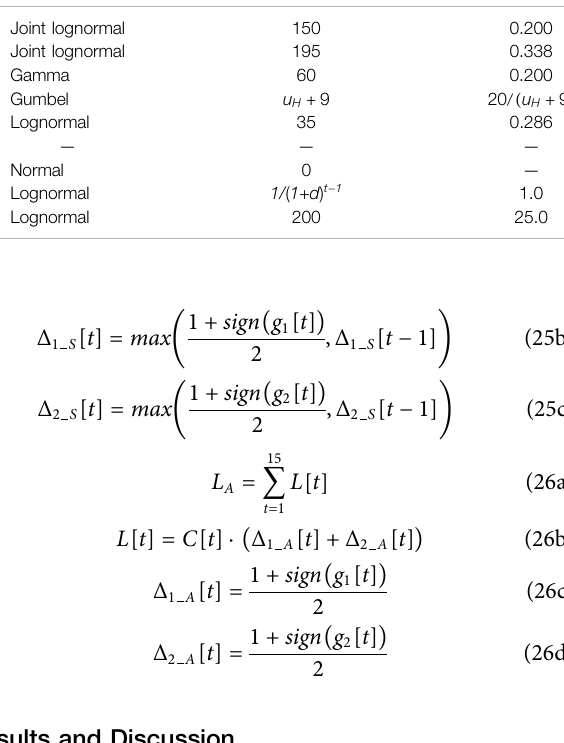
TABLE 3 | A probabilistic model for the two single-bay elastoplastic frames system. Forces are in units of kN and moments in units of kN − m .